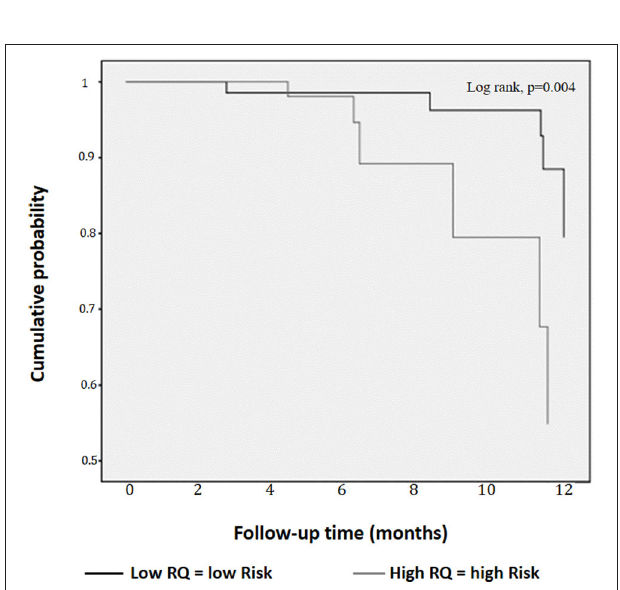
FIGURE 3 | Kaplan-Meier curves for cumulative probability of metabolic syndrome/Type 2 diabetes according to low and high respiratory quotient.